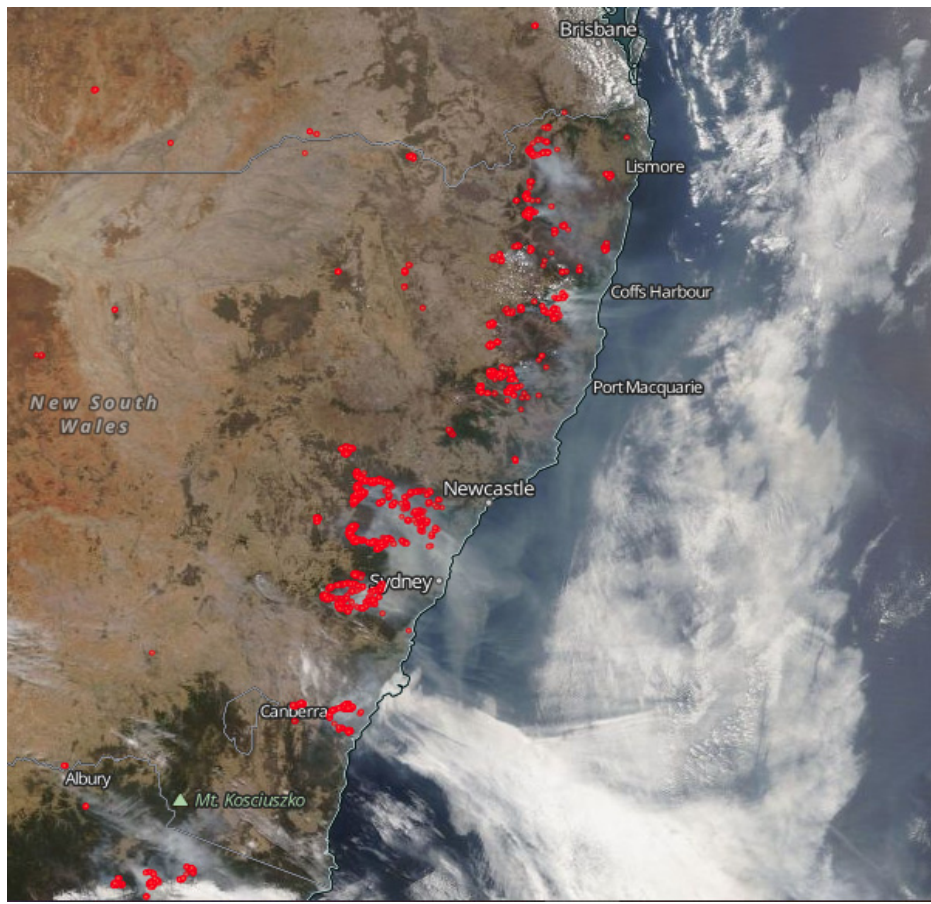
Figure 1. Image from NASA (Aqua and Terra-MODIS satellites) of the huge 10 December 2019 smoke plumes from large NSW bushfires (red dots) that extended along eastern NSW from southern Queensland to south of Canberra.